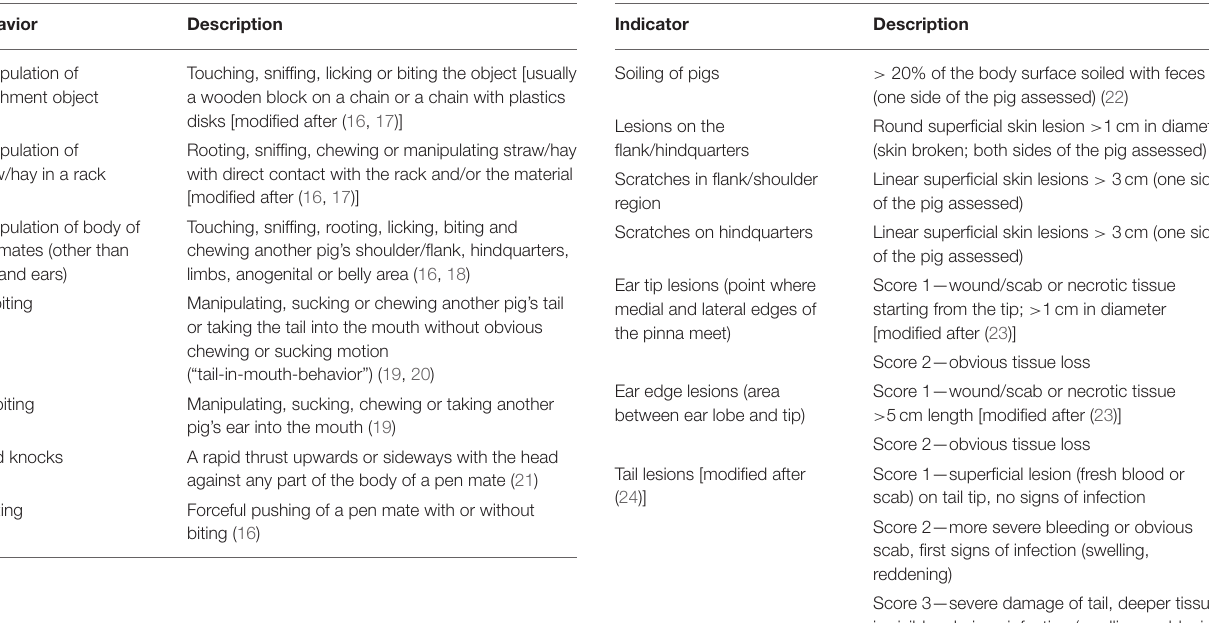
TABLE 2 | Ethogram for continuous behavioral observations. TABLE 3 | Description of assessment of lesions and soiling of